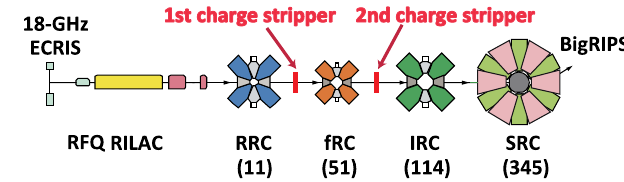
FIG. 2. Acceleration scheme for uranium beams at RIBF. The uranium beams from an 18-GHz electron cyclotron resonance ion source (ECRIS) are accelerated using two linear accelerators, radio-frequency quadrupole linac (RFQ) and RILAC, and four ring cyclotrons, RRC, fRC, IRC, and SRC, for RI beam produc- tion in BigRIPS. Two charge strippers are located downstream of the first and second cyclotrons, RRC and fRC, respectively. The numbers in the brackets below the cyclotrons denote the extrac- tion energies in MeV = nucleon